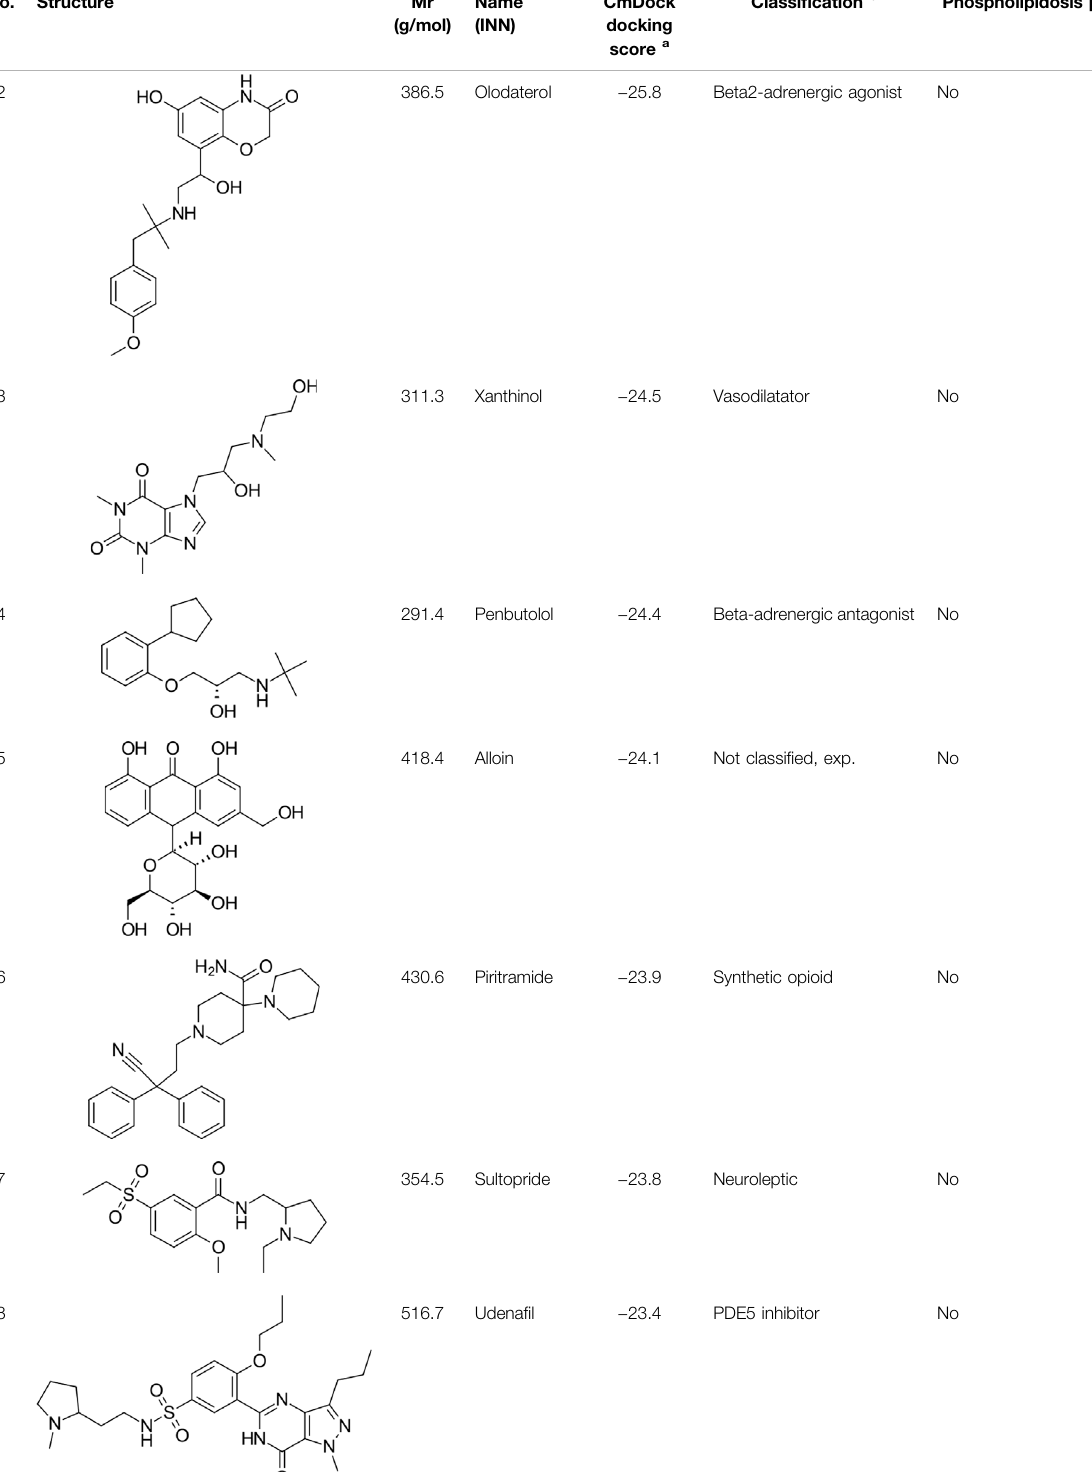
TABLE 2 | Identi fi ed novel drugs in the repurposing experiment with no prior reported 3CL pro activity data. No.